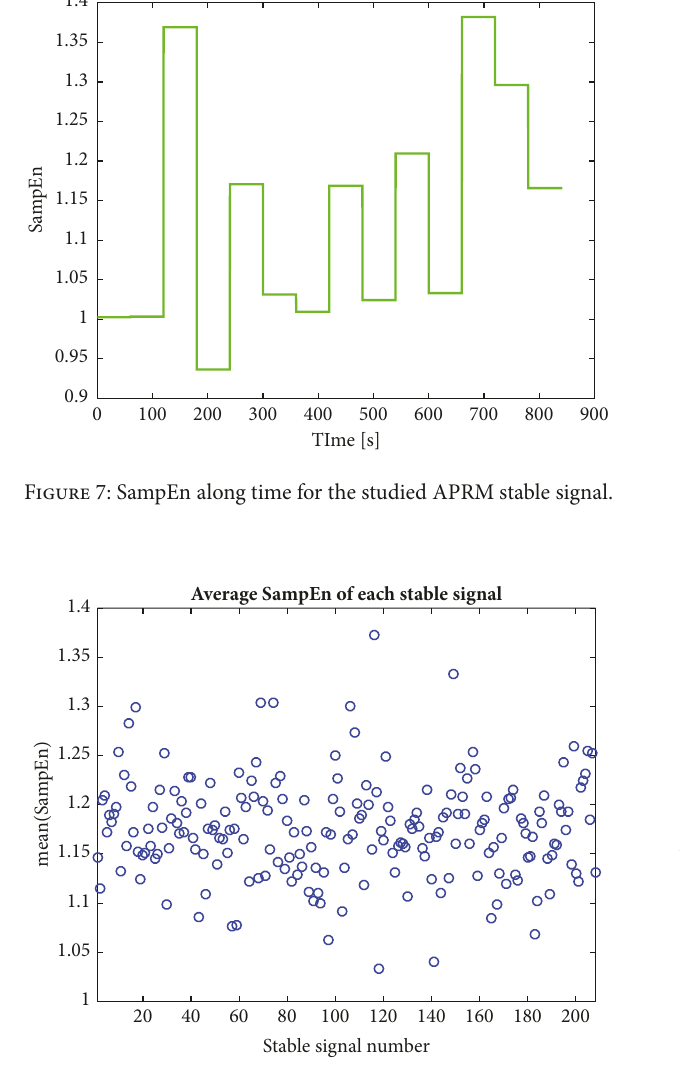
Figure 8: Computed mean(SampEn) of the studied 208 stable signals.